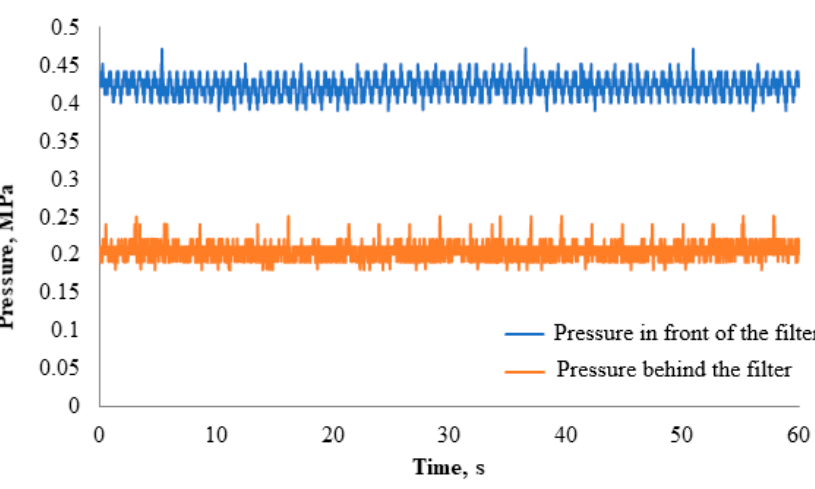
Figure 5. Plot of pressure of uncontaminated oil with CNH Industrial 2992242 filter at 30 °C.